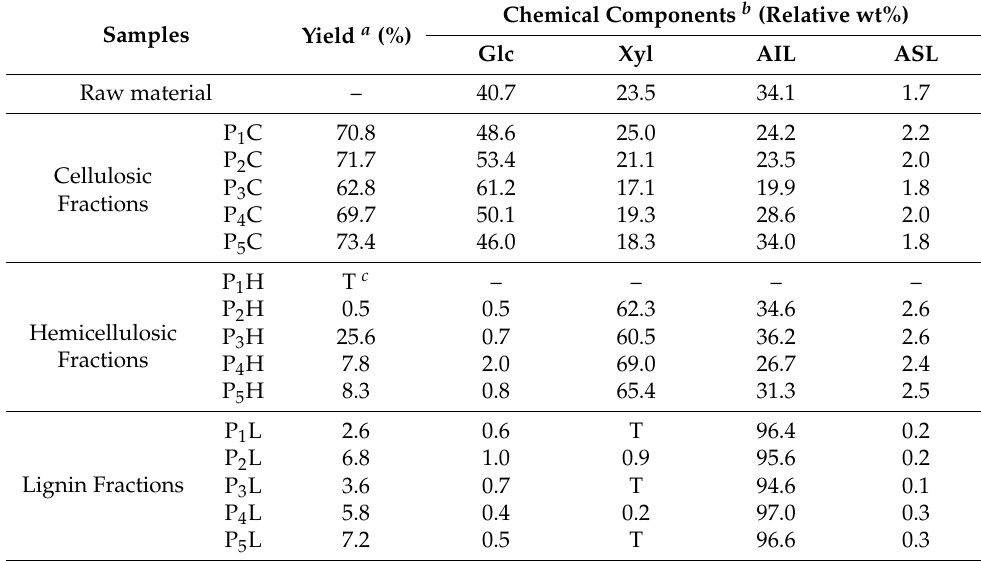
Table 1. Yields and component analysis of the fractionated